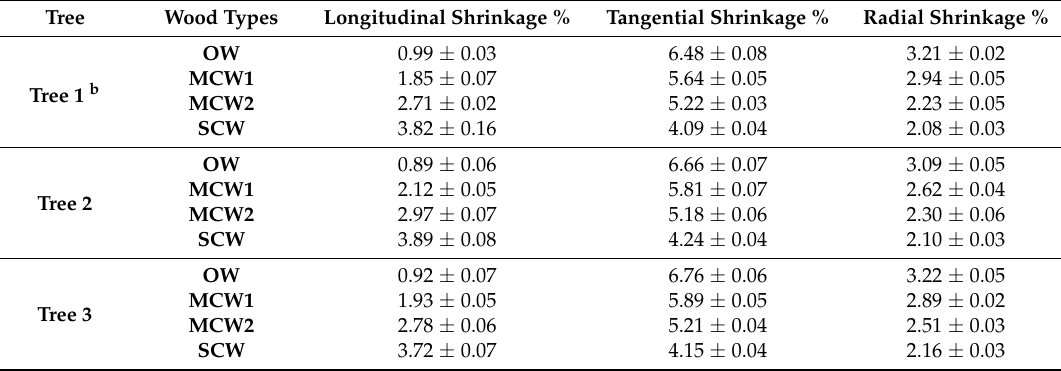
Table 1. Average a shrinkage of tracheids in three directions for all four corewood types of three trees.